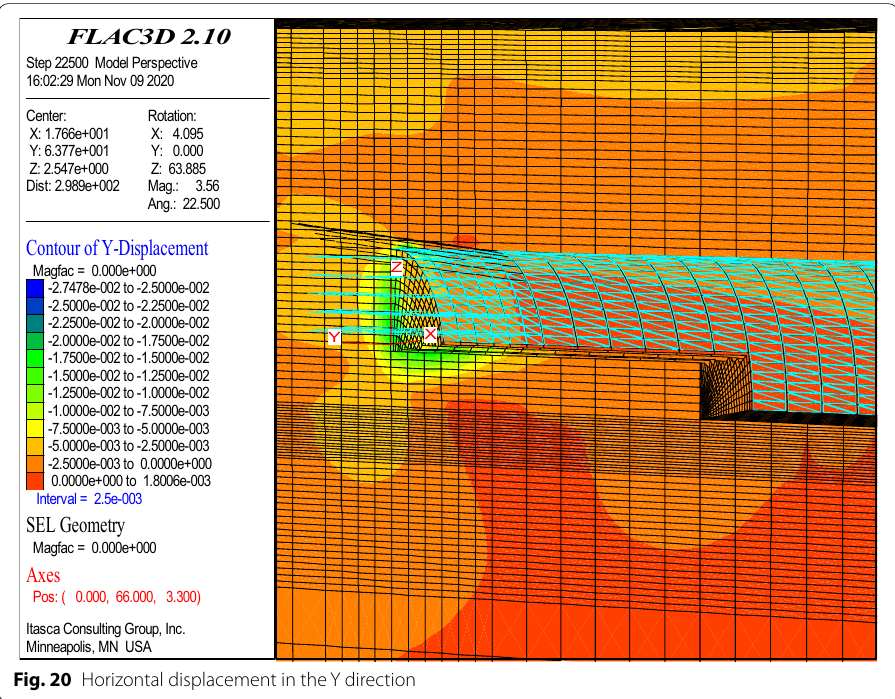
Fig. 20 Horizontal displacement in the Y direction